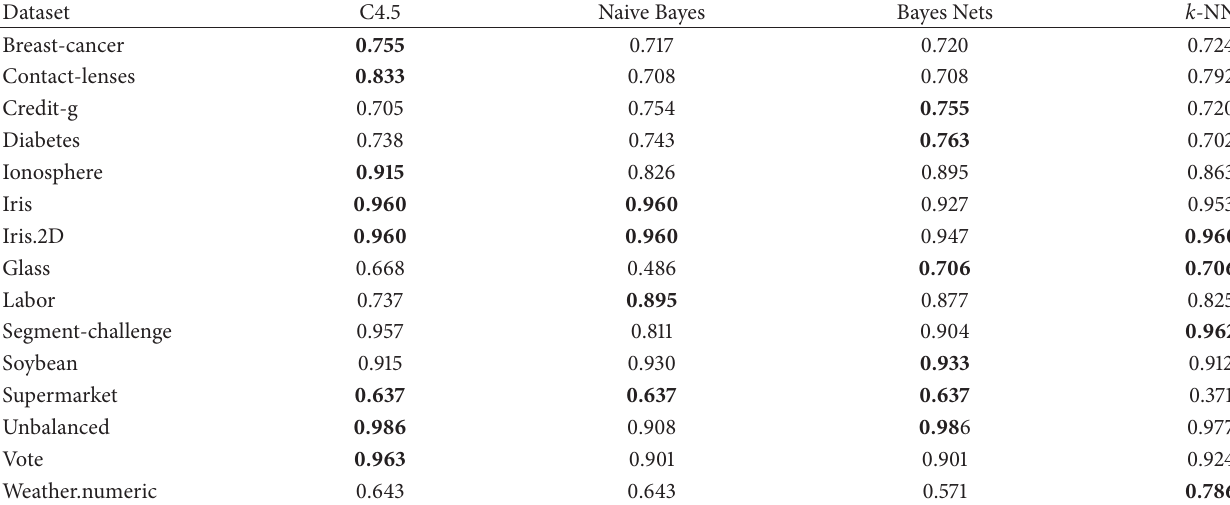
Table 2: Comparison of 4 single methods.